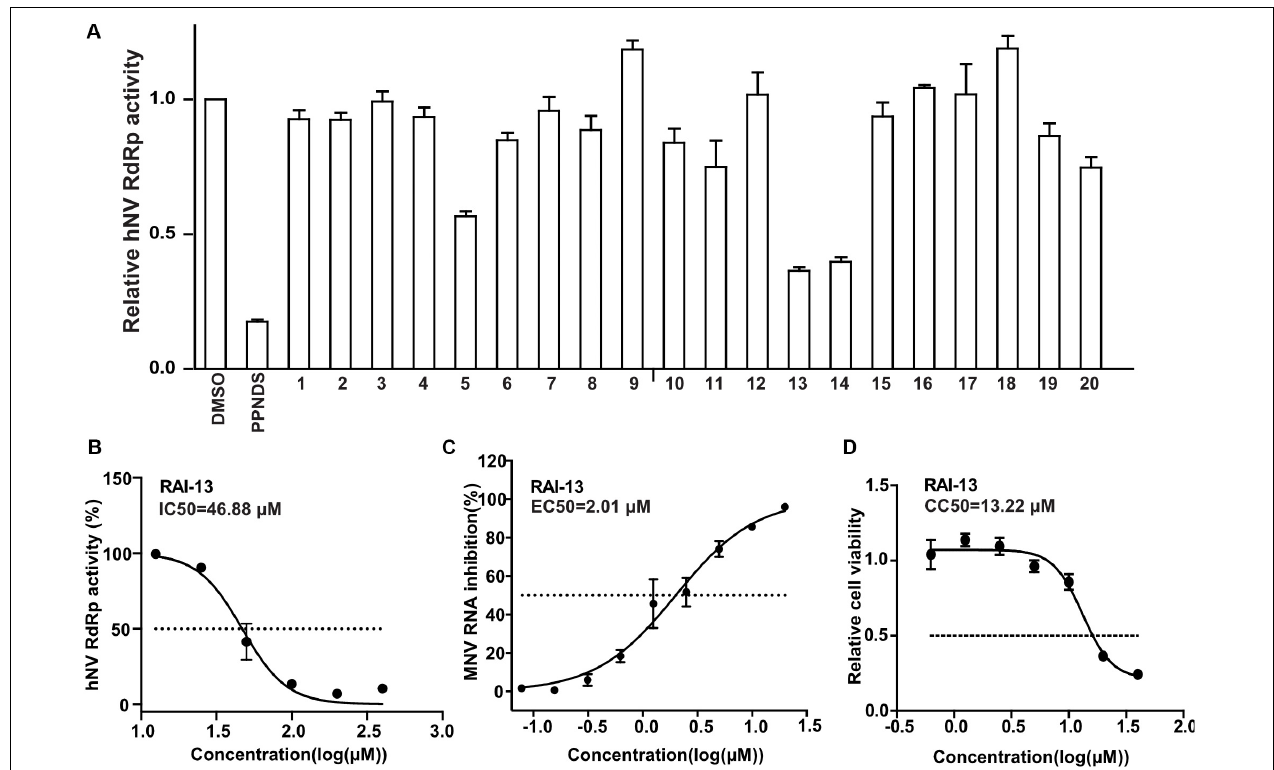
FIGURE 4 | RAI-5, RAI-13 and RAI-14 inhibit the activity of hNV RdRps. (A) The inhibitory effect of screened 20 compounds on the activity of hNV RdRps. hNV-RdRp inhibition assay was performed to measure the inhibition of 20 candidate compounds against activity of RdRp in vitro . Control groups were treated with DMSO (negative control) and PPNDS, a NV RdRp inhibitor (positive control). An average data of three independent experiments is shown, with the value of control arbitrarily set as 1. (B) The inhibitory effect of RAI-13 on hNV RdRp inhibition. Two-fold serially diluted RAI-13 (from 12.5 to 400 µ M) were performed in hNV-RdRp inhibition assay. IC50 values were obtained by non-linear regression analysis using GraphPad 5.0. Data are representative of three independent experiments and normalized to control group. (C) Anti-MNV activity in cell culture. Two-fold serially diluted RAI-13 (from 0.08 to 20 µ M) were incubated with MNV in RAW264.7 cells for 48 h. The inhibition of RAI-13 against MNV replication was measured by detecting MNV RNA through qRT-PCR analysis. EC50 values were obtained by non-linear regression analysis using GraphPad 5.0. The Data are representative of three independent experiments and values are expressed in mean ± SD. (D) The cytotoxicity of the RAI-13 was measured using a Cell Counting Kit-8 by following the manufacturer’s instructions, CC50 values were obtained by non-linear regression analysis using GraphPad 5.0. Data shown are means ± s.d. n =